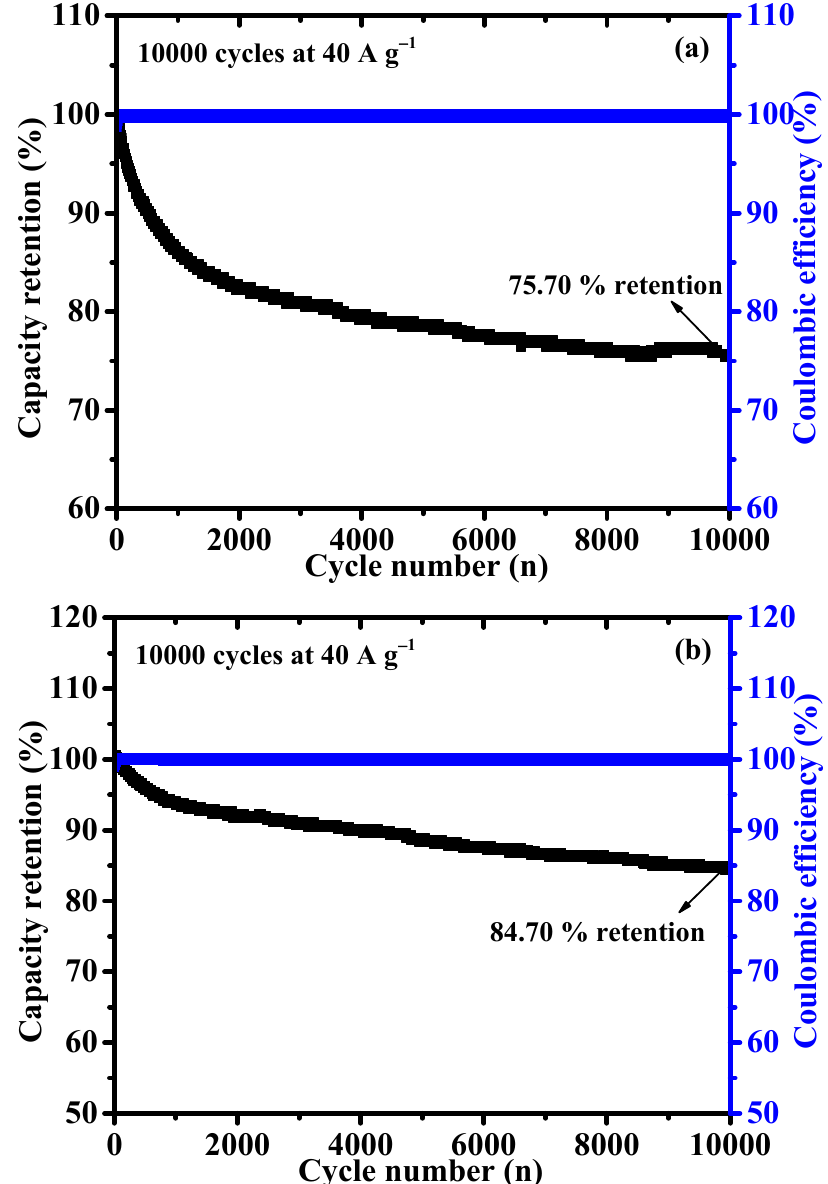
Figure 8. ( a , b ) Long–term cyclability of the NCS and CNS electrode at 40 A g − 1 for 10,000 cycles, respectively.